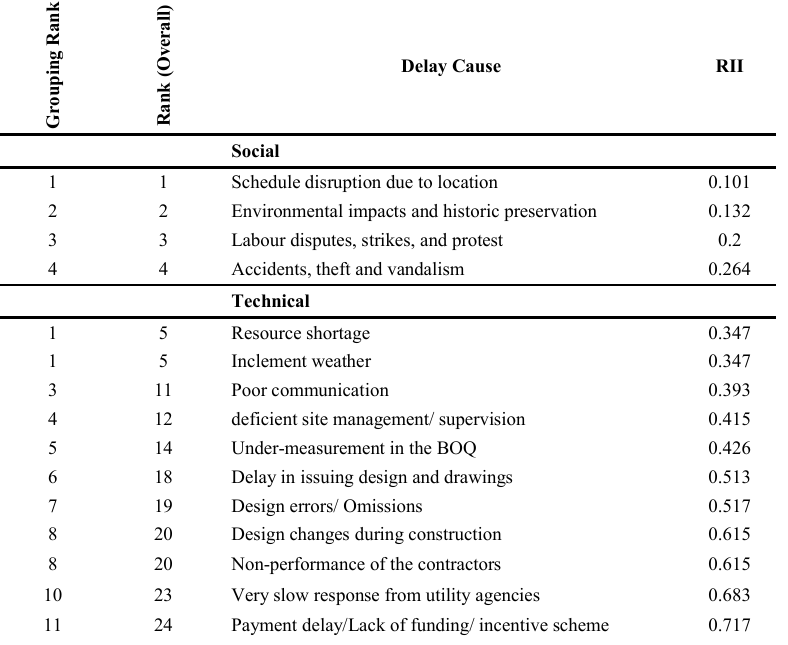
Table 4. Ranking of factors based on the bias score inhibiting effective project time and cost